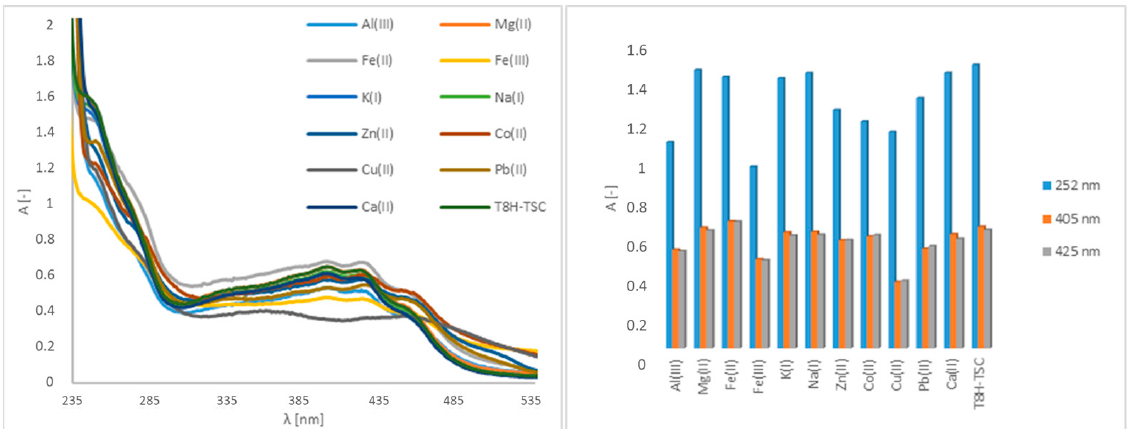
Figure 2. UV ‒ Vis spectra of the T8H-TSC receptor (100 μ M) without and with metal ions (5000 μ M) in water (water/DMSO, 99:1, v / v ), including a bar graph of the absorption maxima (252 nm, 405 nm, 425 nm).